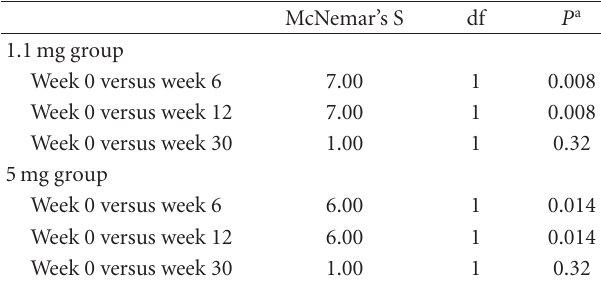
Table 4: Within-group comparisons of the proportion of plasma samples with detectable concentrations of unmetabolized folic